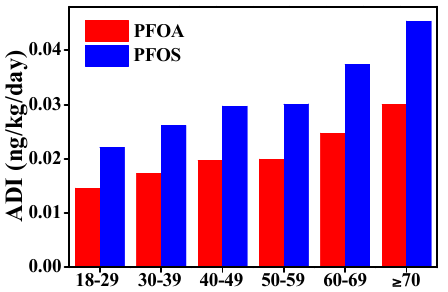
Figure 4. Average daily intake of PFOA and PFOS from milk and dairy products on the basis of body weight (60 kg) by the adults of Xinjiang.